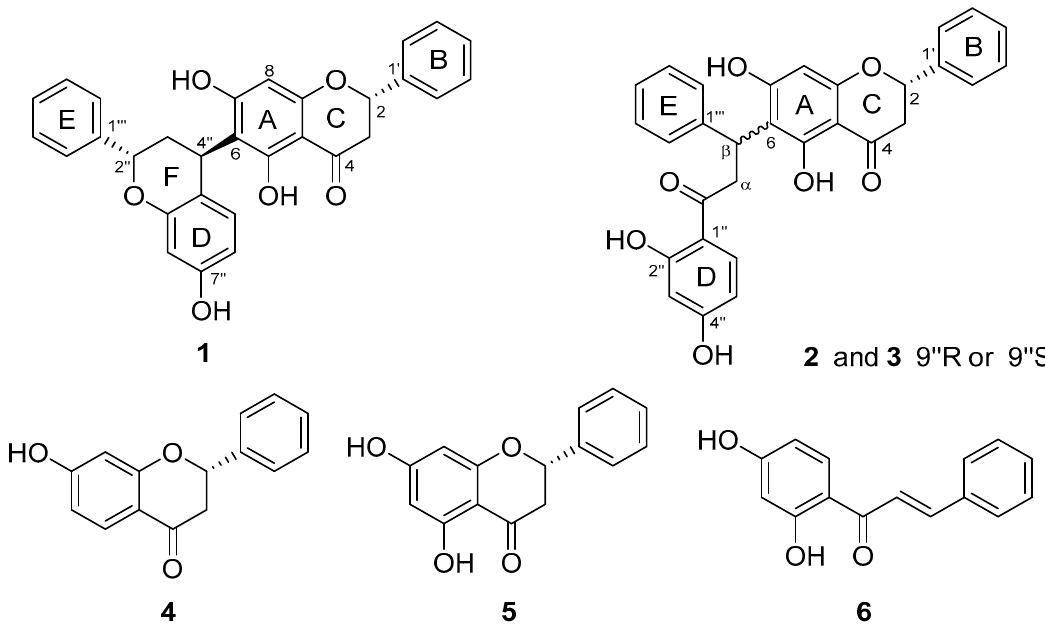
Figure 1. Structures of compounds 1 – 6 .